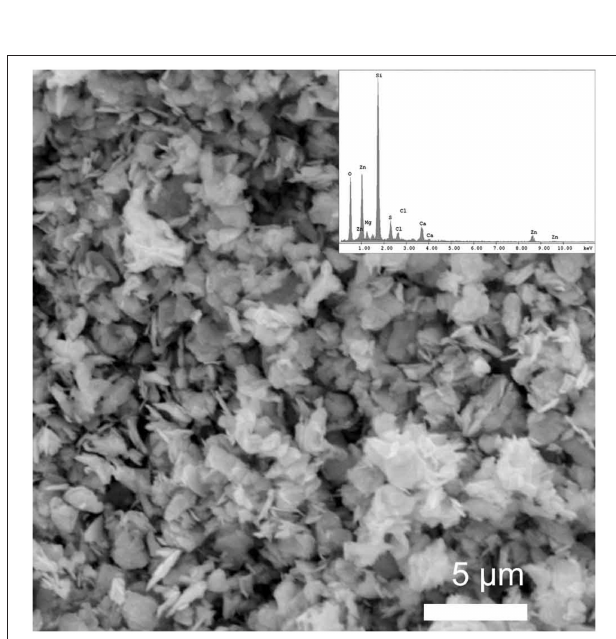
FIGURE 4 | SEM image of ZnS thin film obtained by AACVD of Zn(cinnamtscz) 2 at 450 ◦ C.